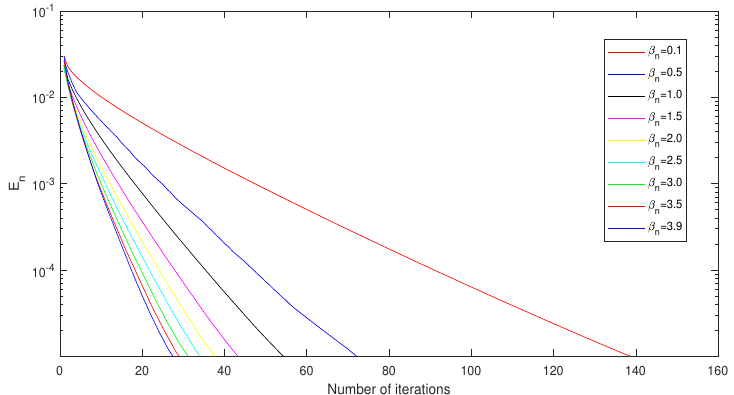
Figure 7. Graph of number of iterations versus E n in case N = 1024 and M = 512.